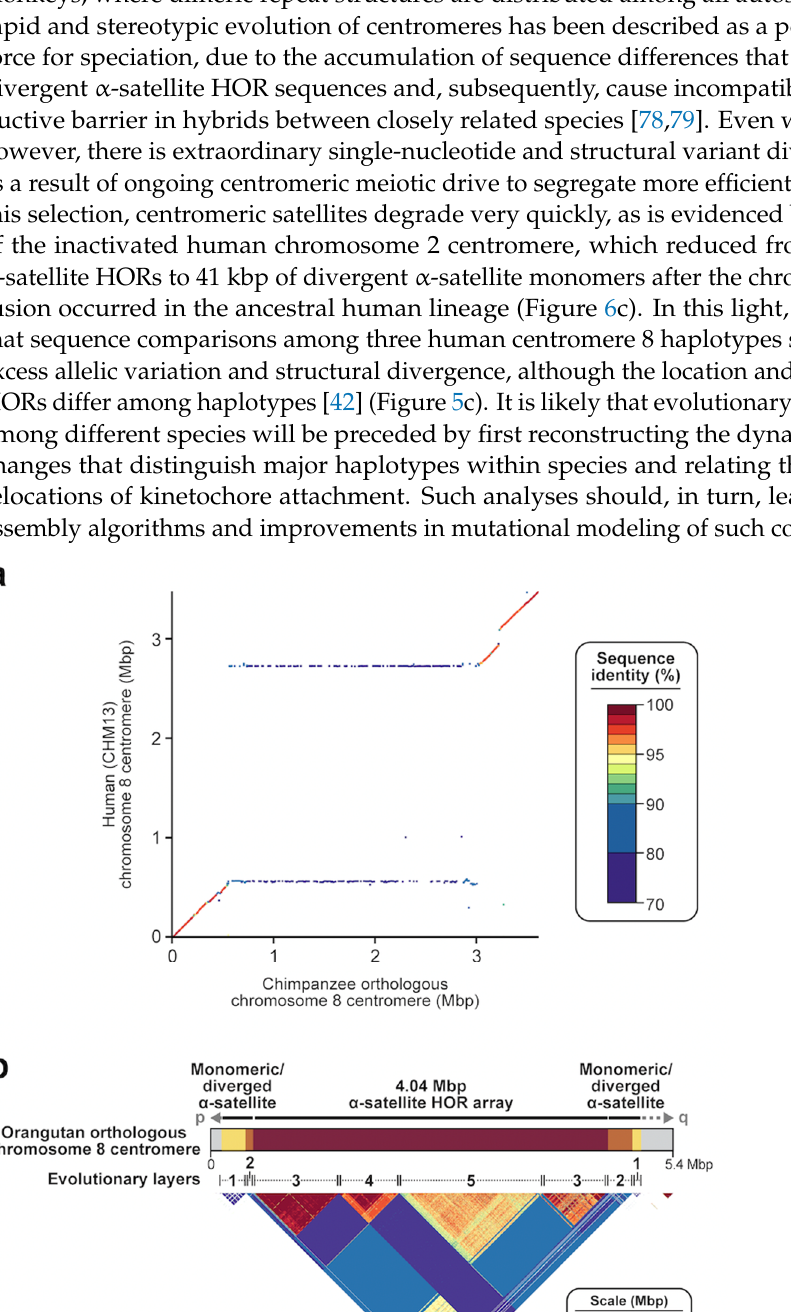
Figure 6. Evolution of centromeric satellite regions. ( a ) Dot matrix plot showing pairwise sequence identity between human (CHM13) and chimpanzee chromosome 8 centromeric regions. While there is >95% sequence identity in the monomeric α-satellite sequences and 70–80% sequence identity in